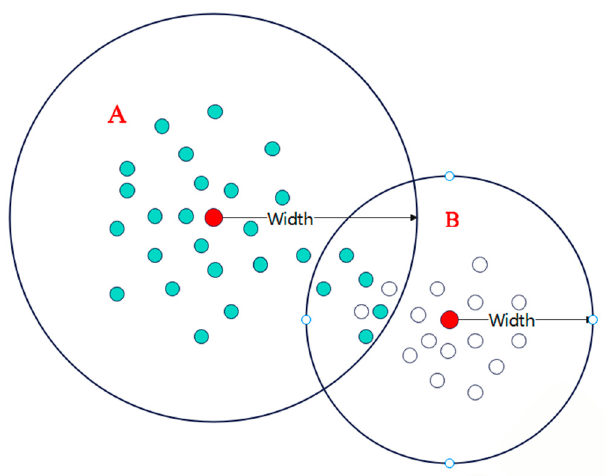
Figure 3. Diagram of the neural network center(bullets represent samples around neurons, and A and B represent two adjacent neurons).